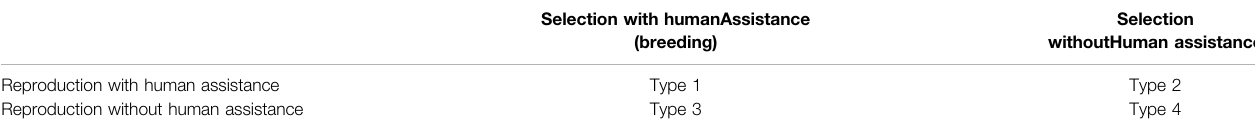
TABLE 1 | Different types of evolving robot systems depending on human